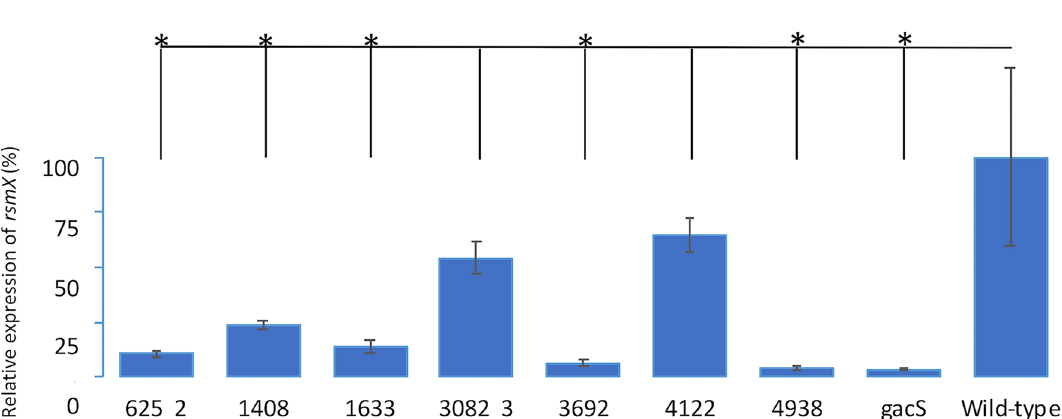
Figure 4. rsmX expression levels. Relative expression of rsmX for the wild-type strain, gacS mutant and gacS mutant complemented with one of seven chimeras belonging to the GacS cluster. The reported values represent the means of three experiments, with standard errors indicated by error bars. All data are presented as a percentage relative to the wild-type. Welch’s heteroscedastic F test was performed and * indicates significantly different comparisons ( p < 0.05) to the